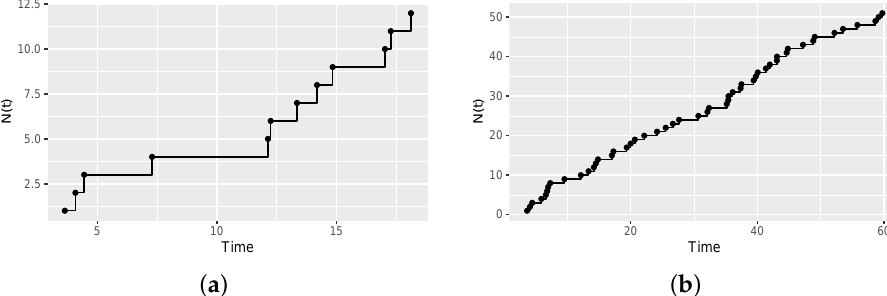
Figure 1. Simulation of a Cox process with n Folded Normal intensity functio with parameters µ = 0, σ 2 = 1 and with covariance function k Z ( h ) = e −| h | for T = 20 ( a ) and T = 60 ( b ).